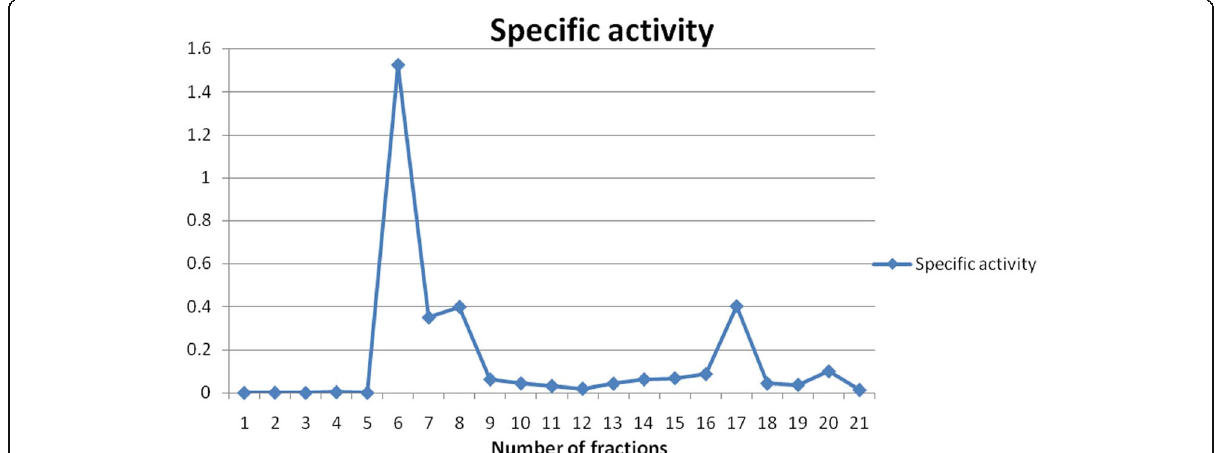
Fig. 1 Purification process of fat body lipase from G. mellonella larvae. Sephadex G-100 gel-filtration of lipase after ammonium sulfate [(NH 4 ) 2 SO 4 ] (40 and 80%) treatment. Fractions number 6 to 21 contained the high enzymatic activity on PNPB (50 mM) and fraction number 6 with the